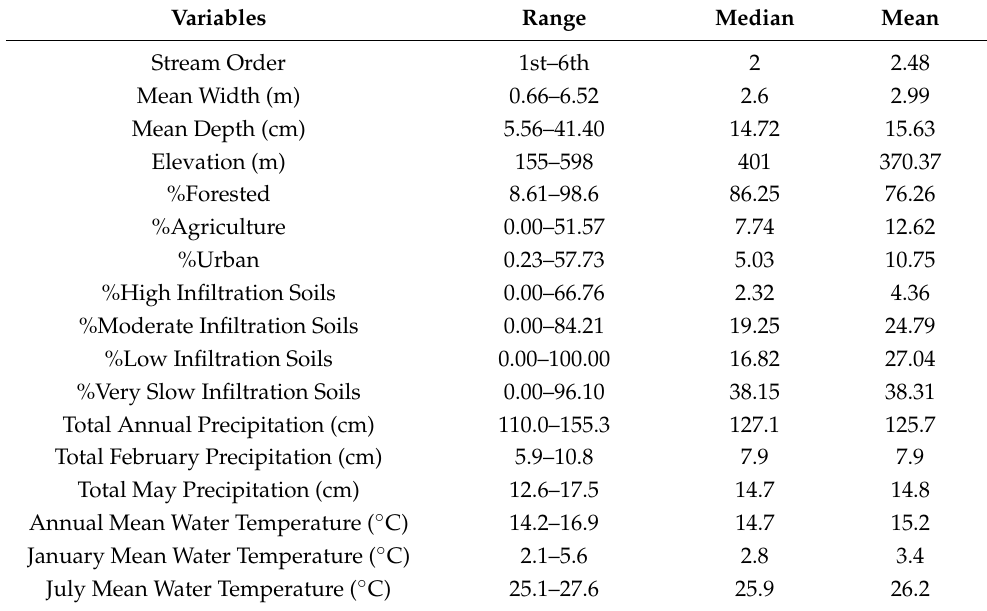
Table 1. The range, median, and mean of each variable across our study